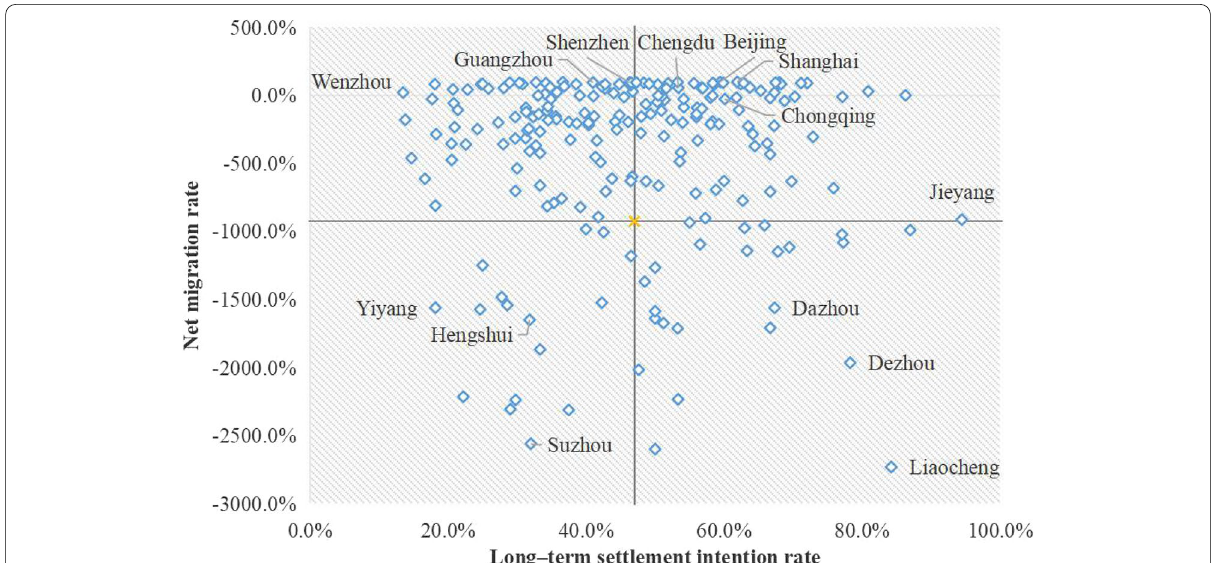
Fig. 7 Four-quadrant diagram of long-term settlement willingness rate and net migration rate. Data source: China Migrants Dynamic Survey (CMDS; 2017)